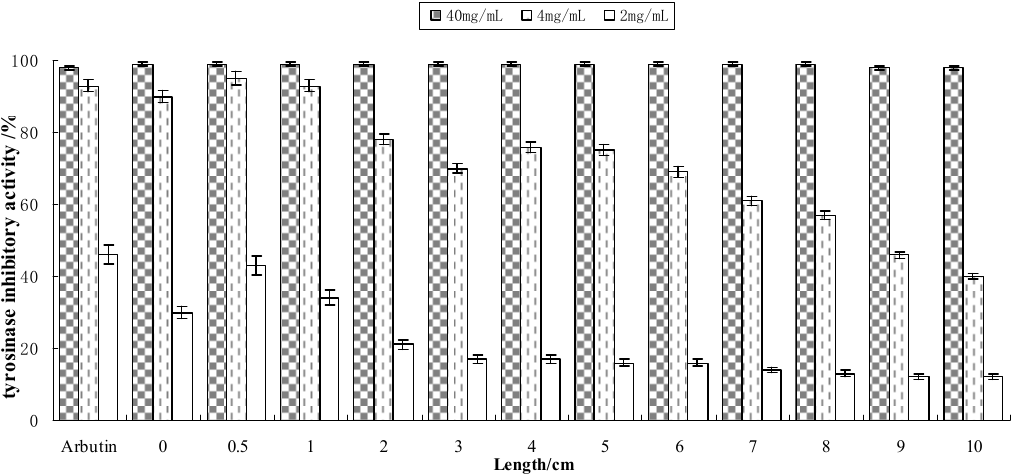
Figure 3. Tyrosinase-inhibition capacity of extracts obtained from different lengths of bean sprouts (n =